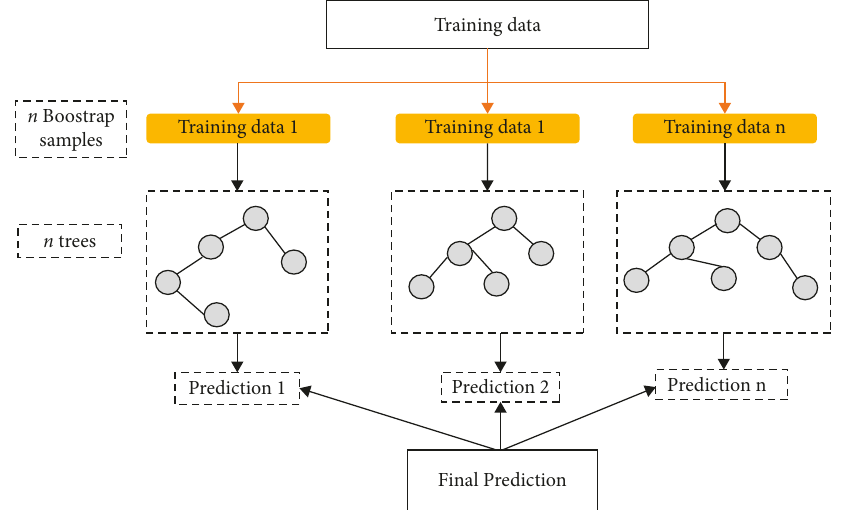
Figure 1: Schematic diagram of the RF